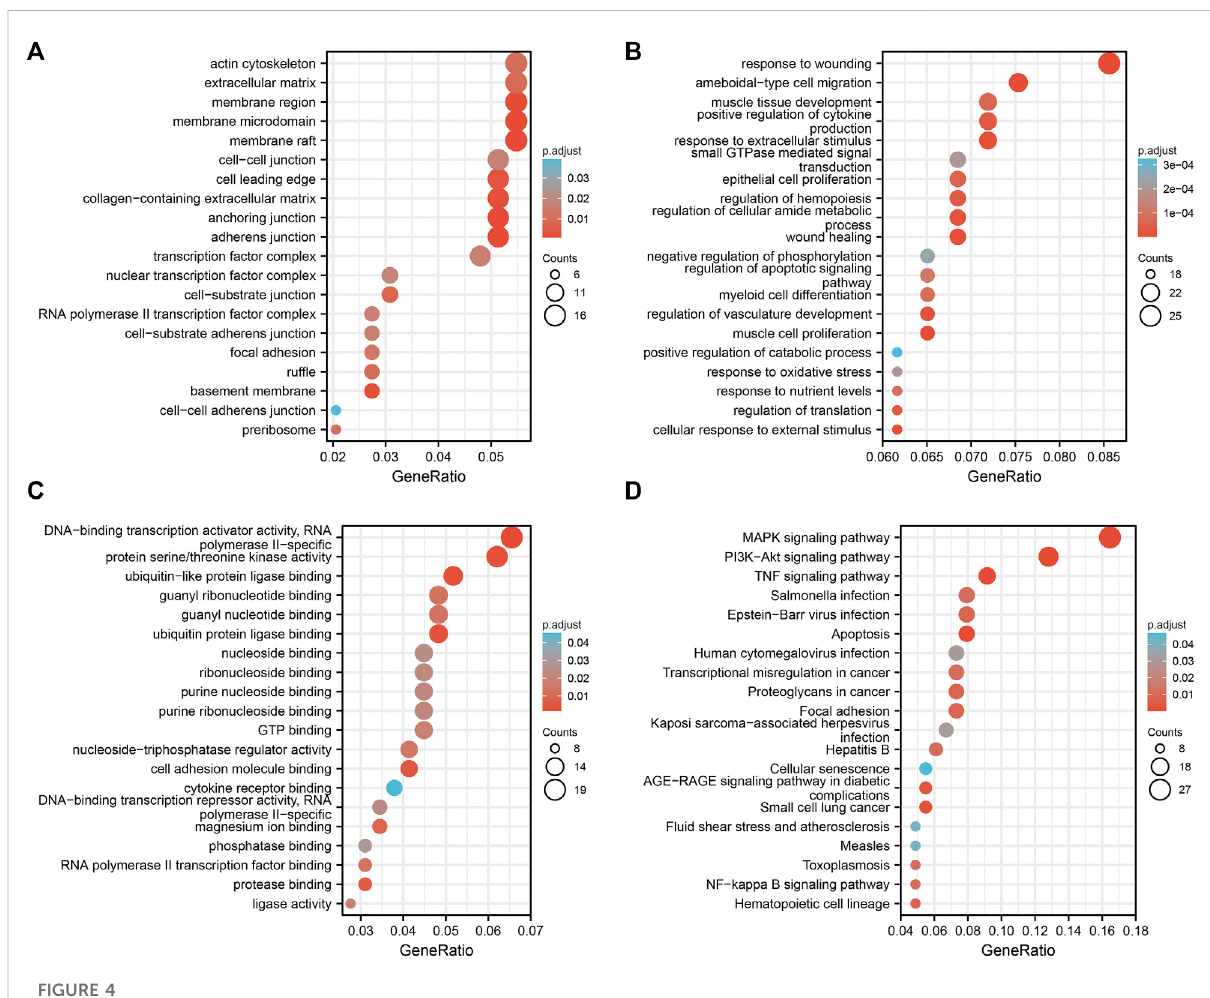
FIGURE 4 GO/KEGG enrichment analyses of common differential